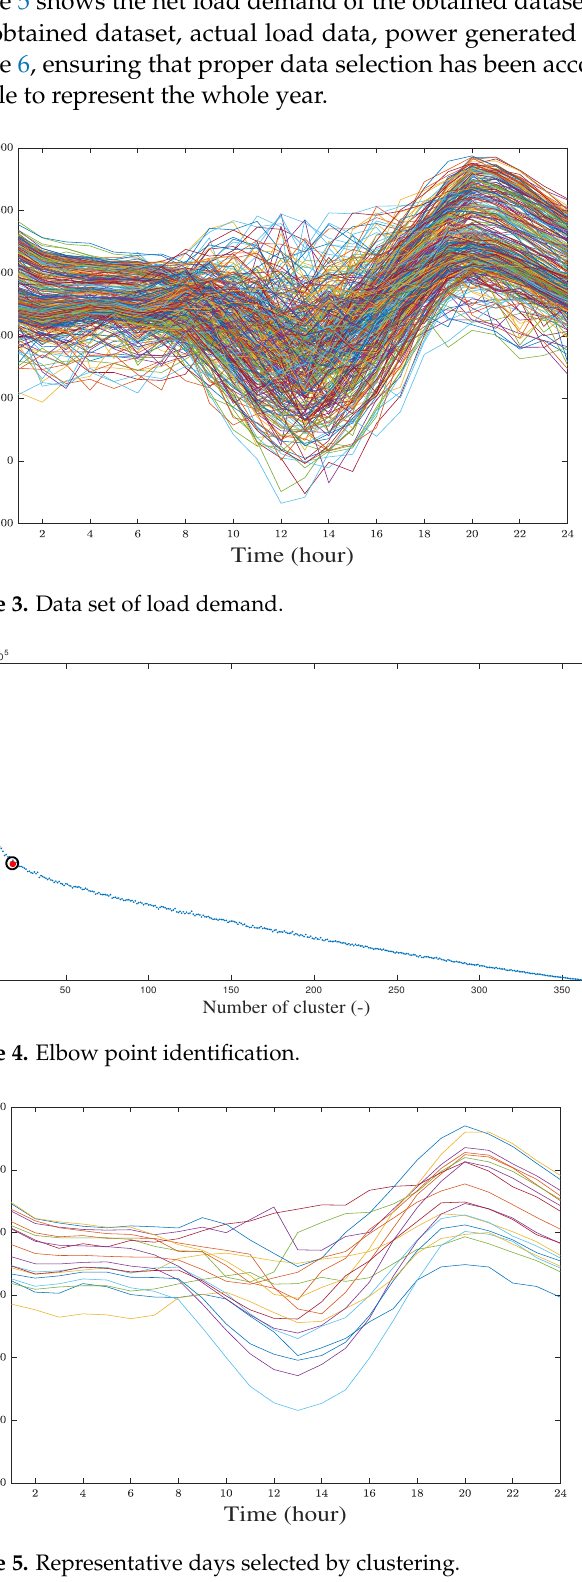
Figure 5. Representative days selected by